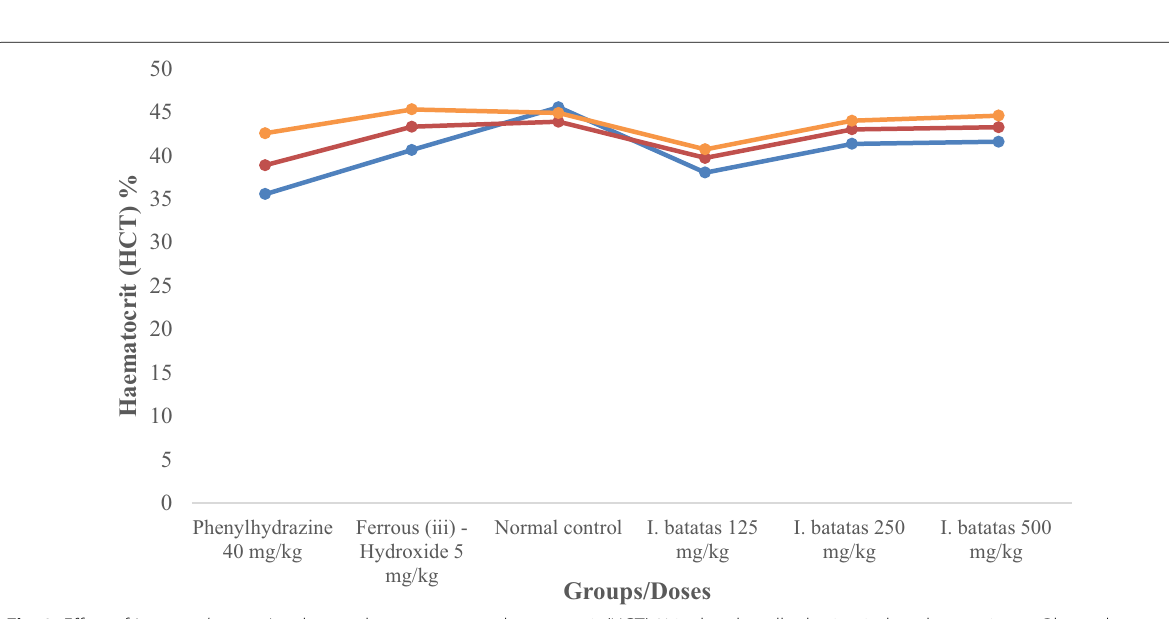
Fig. 3 Effect of Ipomoea batatas L . n-hexane leaves extract on haematocrit (HCT) % in the phenylhydrazine-induced anaemic rats. Blue—day 1, red—day 7, orange—day